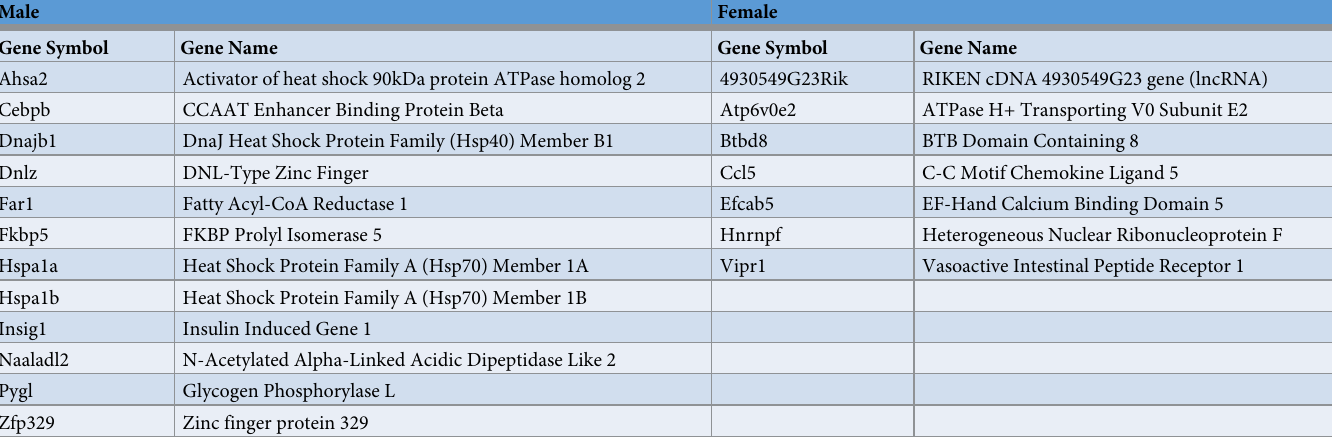
Table 4. Genes Differentially Expressed between CIE and Air C57Bl/6J Mice in Blood and PFC with Expression Levels that are also Correlated between Blood and